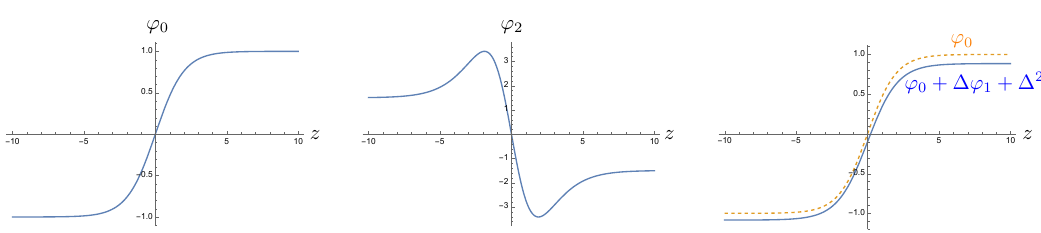
Figure 2 . Bounce field configuration in D = 4 with ∆ = 0 . 1 . Left: leading order ϕ 0 , center: ϕ 2 from (4.7) and on the right: ϕ = ϕ